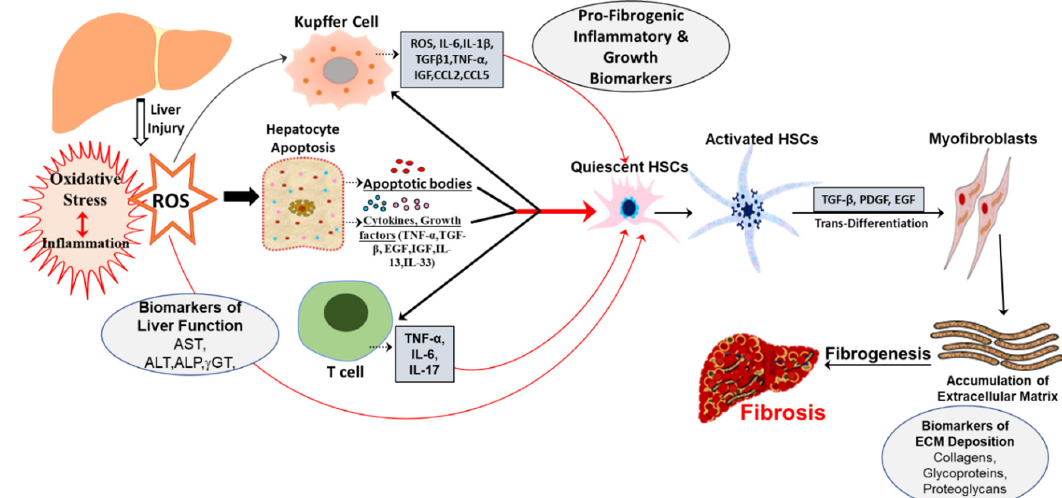
Figure 1. Schematic representation of pathogenic events and oxidative stress mediated biomarkers in hepatic fibrosis. Liver injury may be caused by multiples etiologies, including metabolic syndrome, NASH, NAFLD and ALD, that trigger oxidative stress and hepatic inflammation through di ff erent types of cells. This results in the generation of ROS / RNS that, in turn, induce apoptosis with the release of cytokines, chemokines, growth factors. These factors collectively enhance the activation of HSCs that ultimately leads to fibrosis.